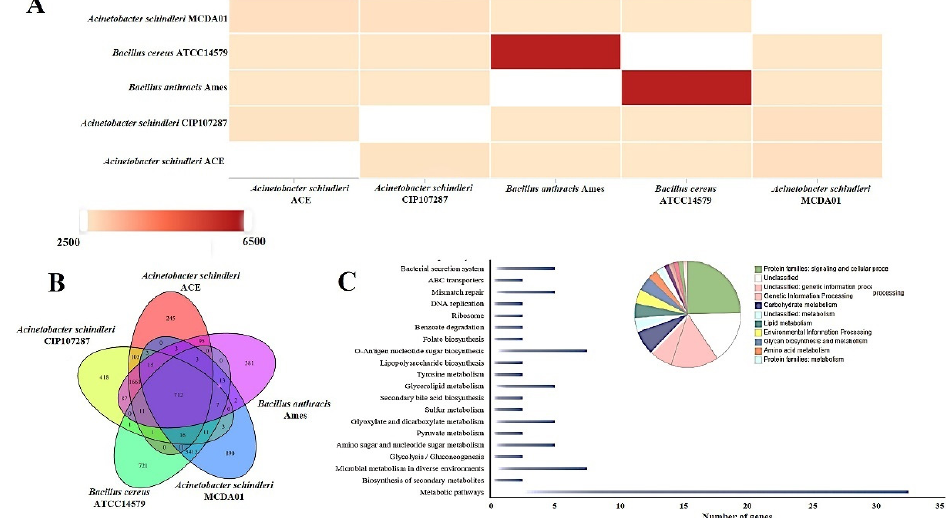
Figure 2. Comparative genome analysis of Acinetobacter schindleri MCDA01, Acinetobacter schindleri CIP107287, Acinetobacter schindleri ACE, Bacillus anthracis Ames, and Bacillus cereus ATCC14579: ( A ) similarity relations of genomes between four strains; ( B ) unique genes of the genomes of four strains; ( C ) KEGG pathway classification of these unique genes from the genome of Acinetobacter schindleri MCDA01.